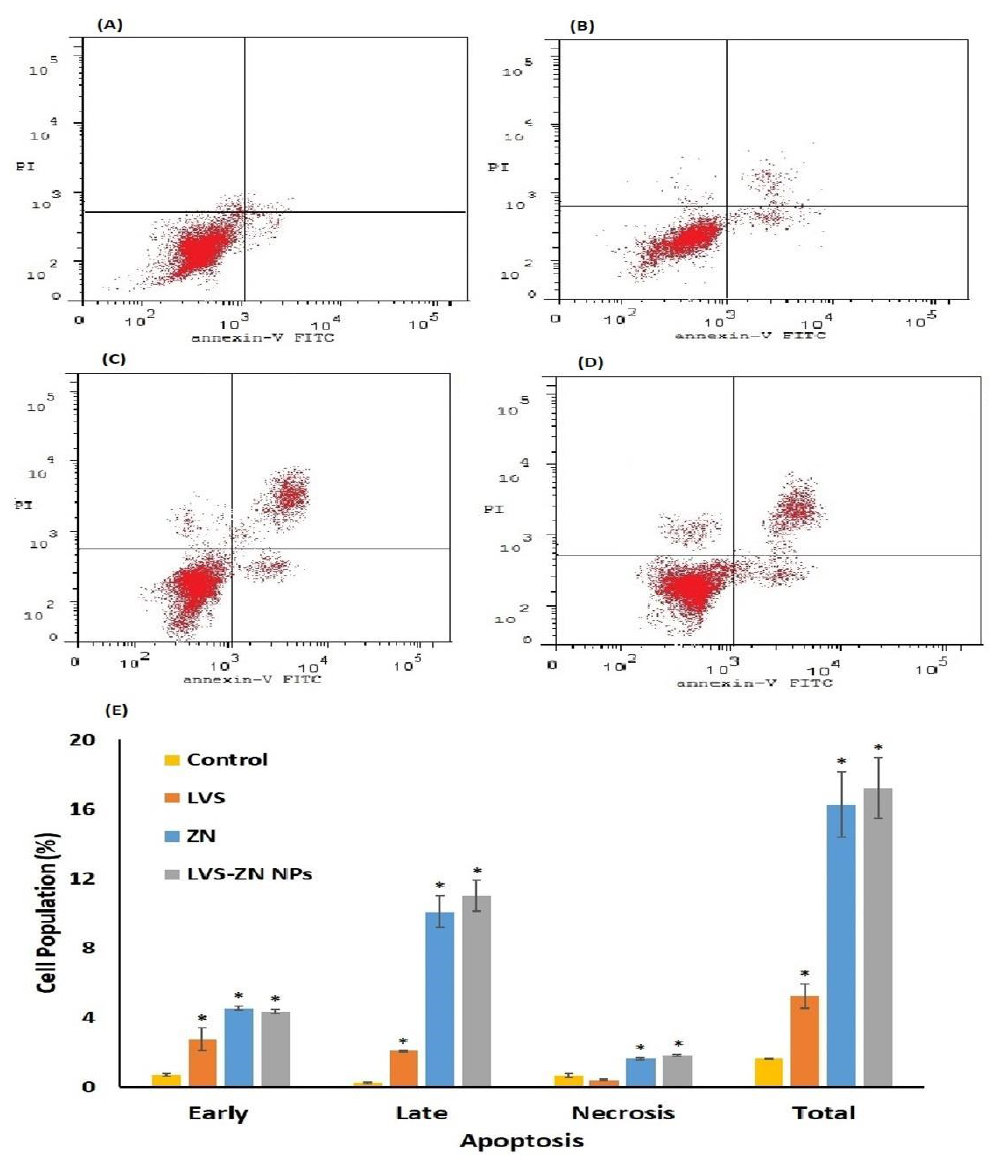
Figure 7. Impact of the LVS-ZN NPs on the annexin-V FITC positive-staining HepG2 cells. ( A ) Control, ( B ) raw LVS, ( C ) ZN, ( D ) LVS-ZN NPs, and ( E ) graphical presentation of early and late apoptotic, necrotic, and total cell death. * Significantly di ff erent ( p < 0.05) compared to the corresponding